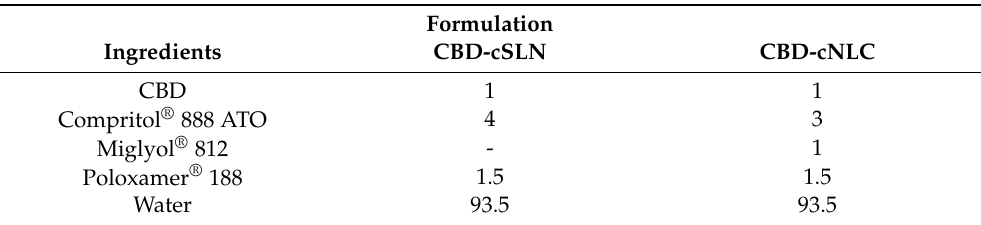
Table 5. The lipid nanoparticle dispersions (% w / w ) were composed of Compritol ® 888 ATO (solid lipid) to obtain CBD-cSLN and CBD-cNLC.